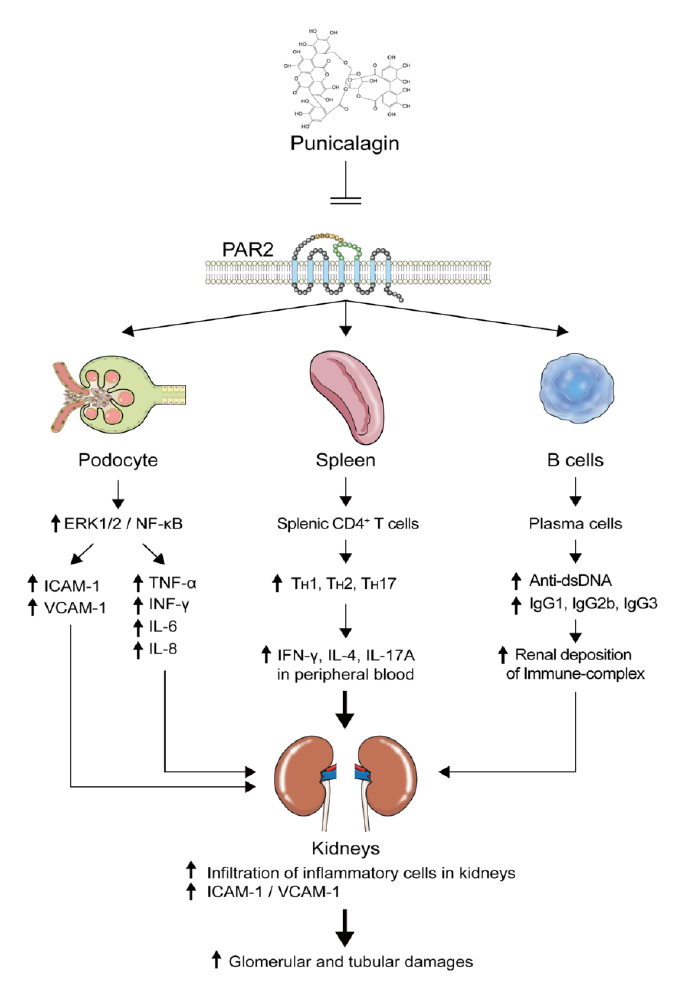
Figure 8. Schematic overview of the inhibitory effect of PCG on lupus nephritis in human podocytes and NZB/W F1 mice.